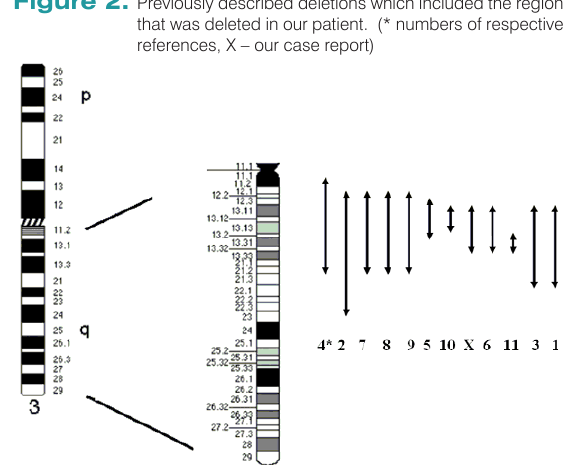
Figure 2. Previously described deletions which included the region that was deleted in our patient. (* numbers of respective references, X – our case